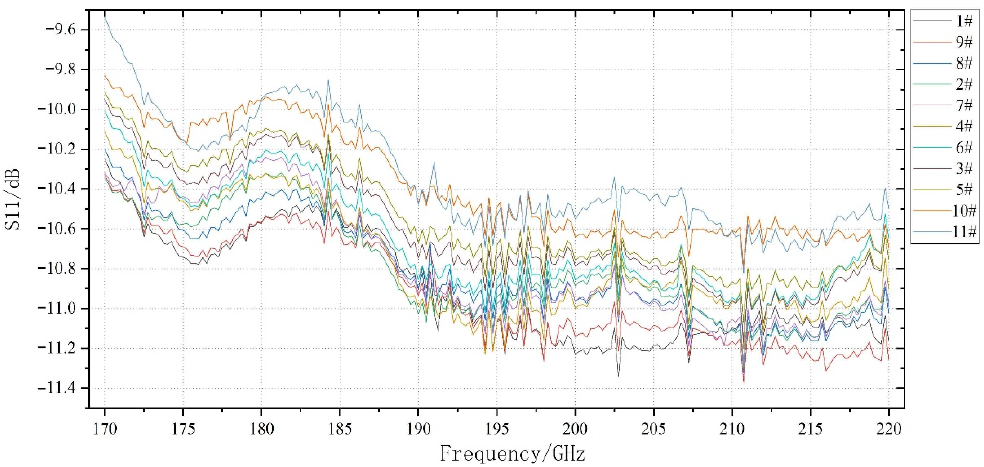
Figure 17. S11 parameter curve diagram of 11 sets of samples.